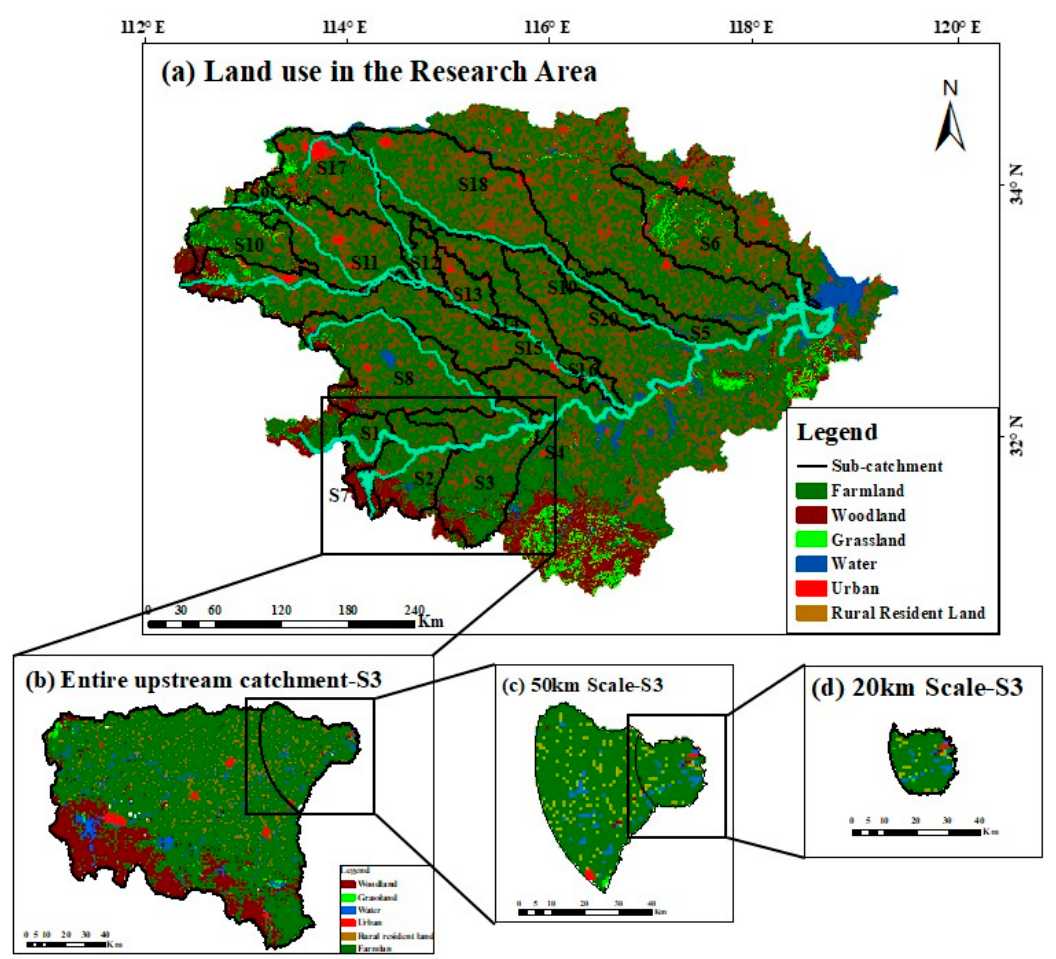
Figure 2. ( a ) The map shows the upper and middle reaches of the Huaihe River Basin. The different colors represent different types of land use. The examples of spatial scales definitions were shown by ( b ) the entire upstream catchment (EUC), ( c ) 50 km radii around the monitor station and ( d ) 20 km radii around the monitor station. The definitions of 10, 15, 30 and 40 km radii scales were similar.